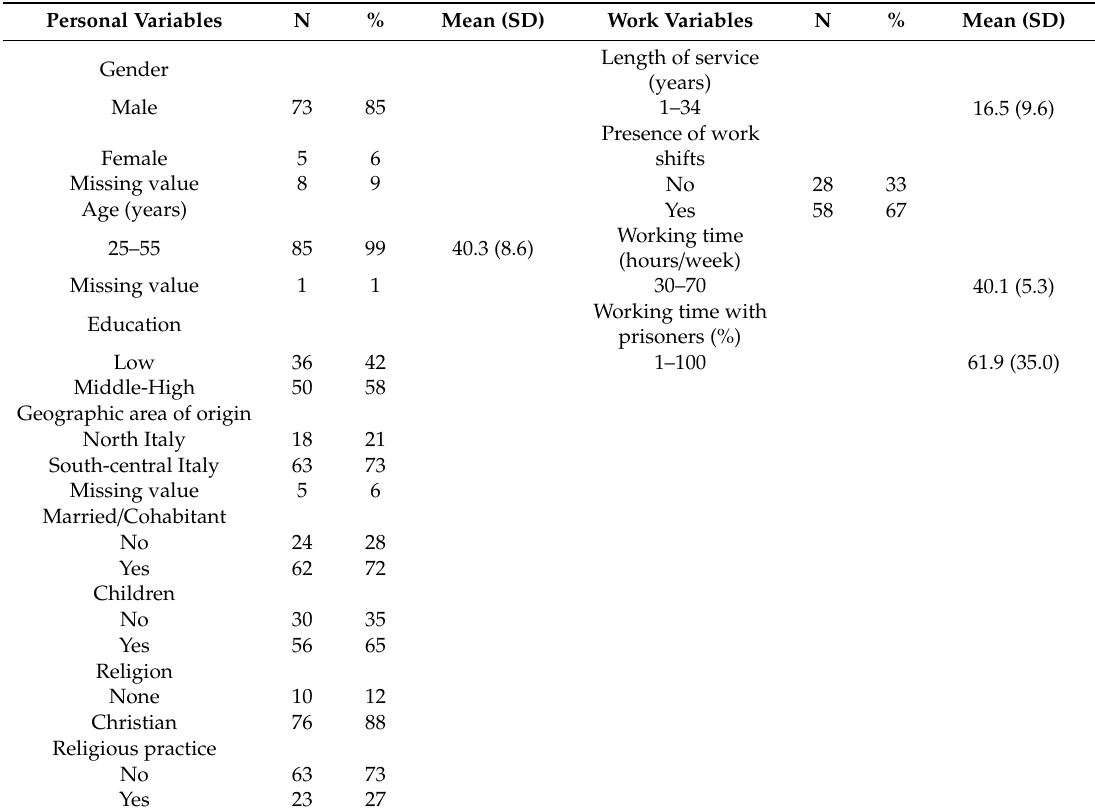
Table 1. Participants